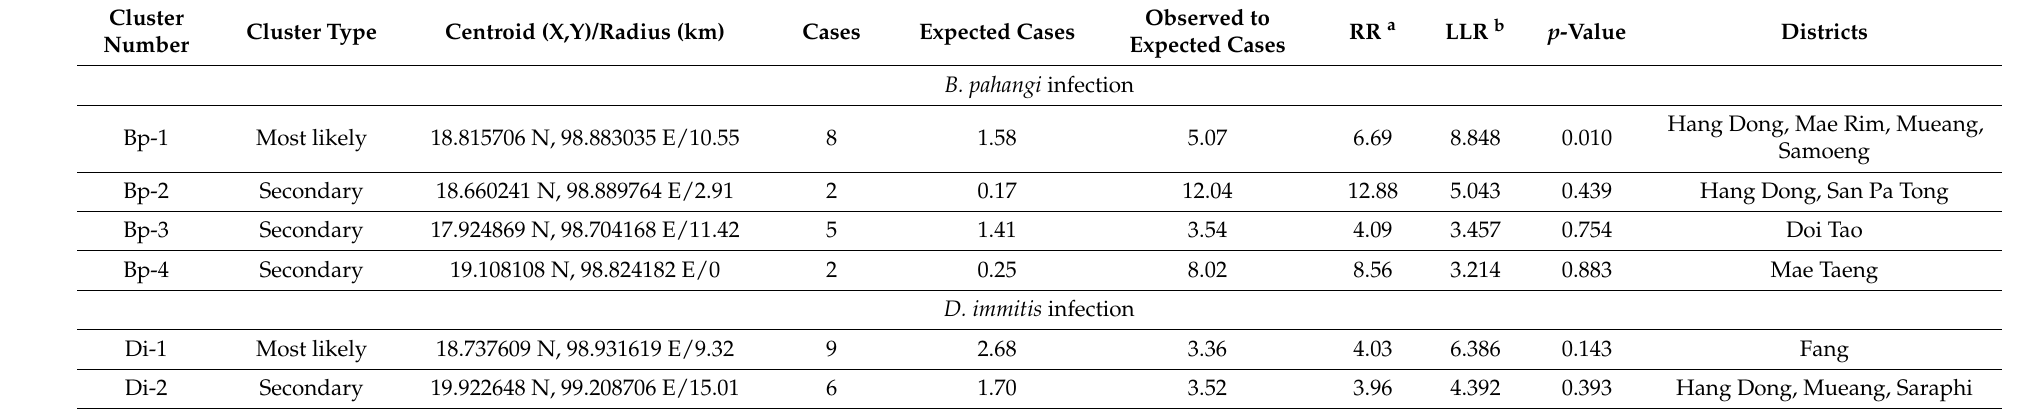
Table 4. Geographic spatial clusters obtained by Bernoulli scan statistic model on canine filariasis in Chiang Mai,